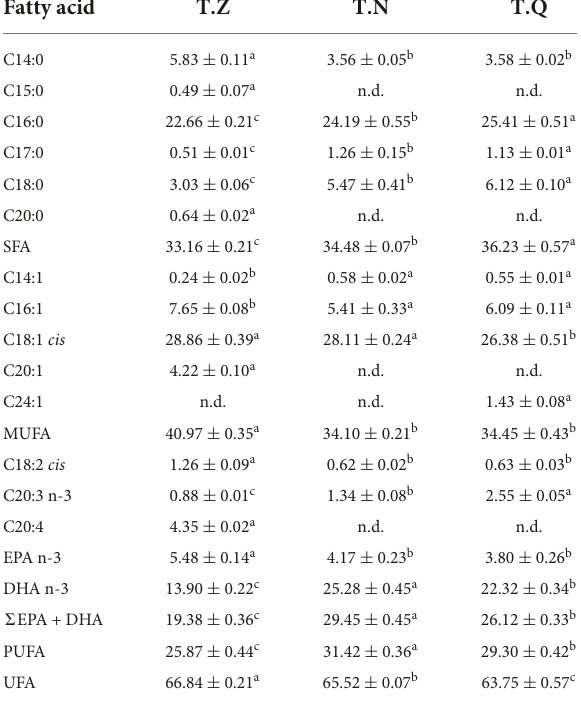
TABLE 6 Hairtail muscle fatty acid composition from three different sources